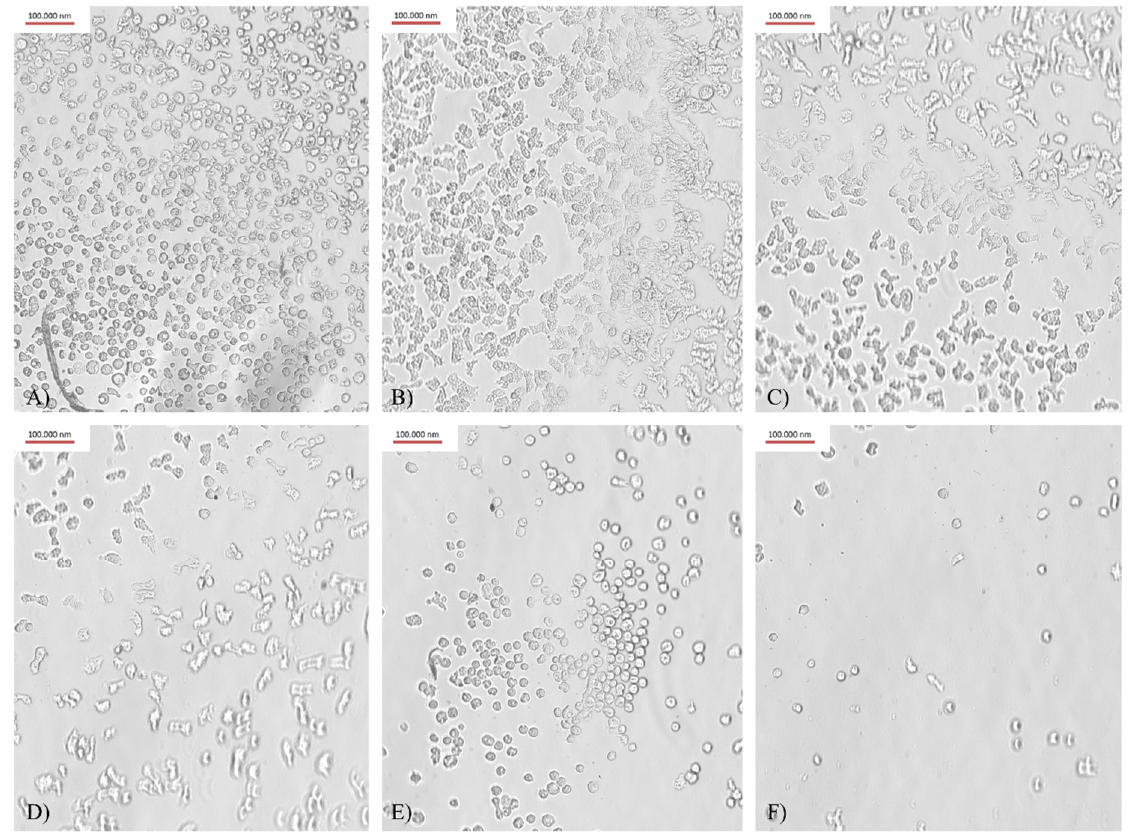
Figure 2. Trophozoites adhered to FDA group 3 contact lenses’ surface after 4 h of incubation (×400 magnification): ( A ) water control; ( B ) SCA solution control; ( C ) SCA + 1.25 ppm AgTANPs; ( D ) SCA + 2.5 ppm AgTANPs; ( E ) SCA + 5 ppm AgTANPs; ( F ) SCA + 10 ppm AgTANPs. The AgTANPs dose ‐ dependent adhesion reduction (AR) in trophozoites is visible in the photos ( C – F ).